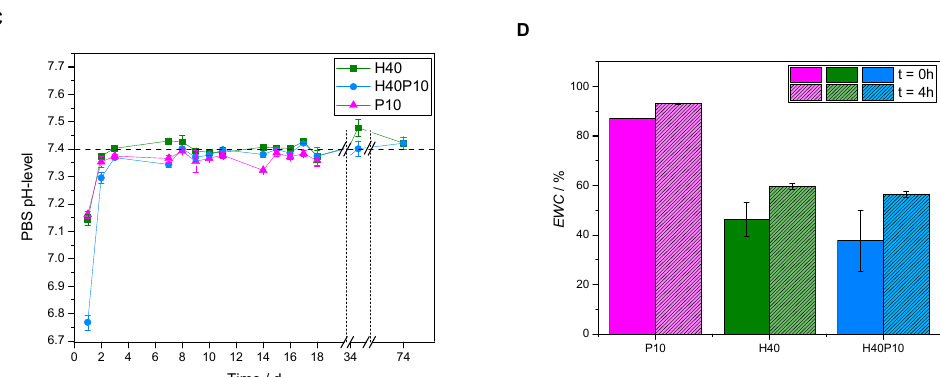
Figure 3. Overview of the gel characterization for the specimens with 40 wt% HEMA (H40), a combination of HEMA and cross-linker (H40P10) and the pure PEG-PLLA_DMA triblock hydrogel with 10 wt% polymer (P10). The different batches were analyzed regarding mass development in PBS buffer at pH 7.4 ( A ), pH-level of the storage medium ( C ) as well as EWC ( D ). Additionally, a schematic curve of the degradation study corresponds to obtained data ( B ).